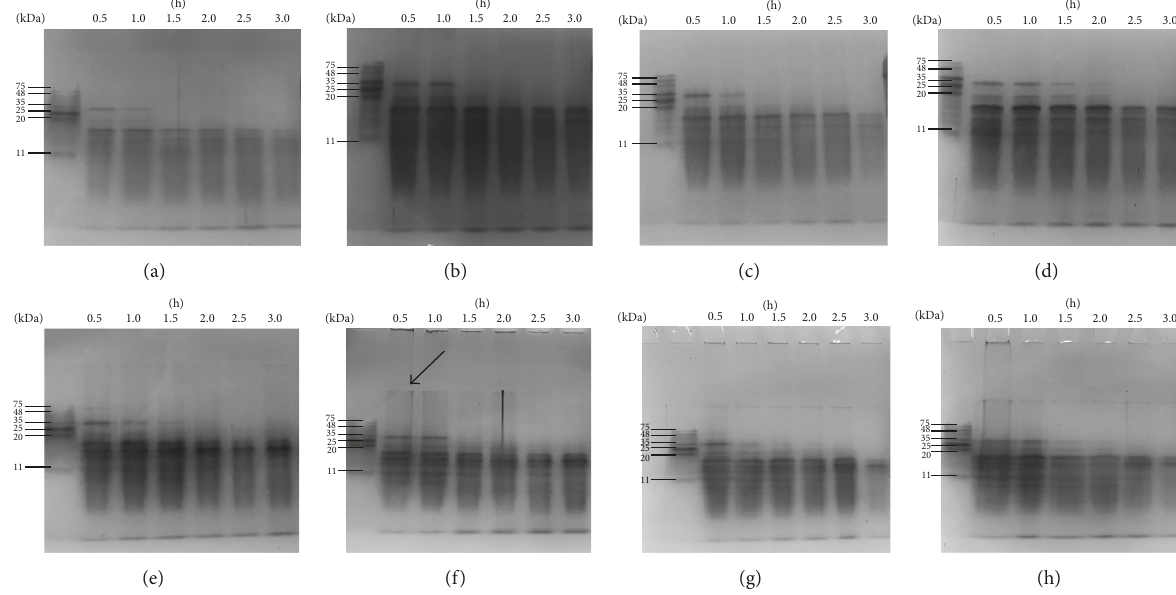
Figure 2: Reducing (a–d) and nonreducing (e–h) SDS-PAGE images of untreated and extruded HSPP samples: (a & e) nonextruded, (b & f) Ex60-HSPP, (c & g) Ex80-HSPP, and (d & h)